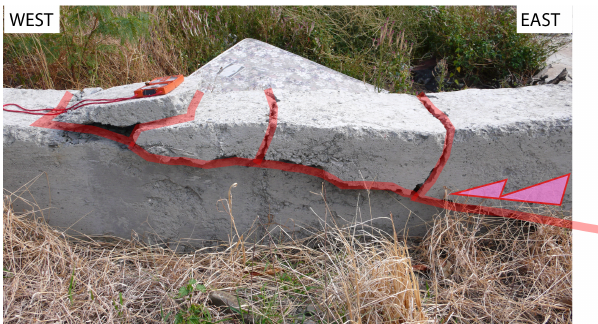
Figure 6. Field photograph of compressive features affecting re- cent concrete dykes after the Hengchun earthquake (26 Decem- ber 2006, M L = 7.0); see location in Fig. 1 near the Fang-Shan village (22.26 ◦ N, 120.66 ◦ E). The red compass gives the scale of the outcropping deformation (20cm). The thrust is associated with three back thrusts, highlighting a small pop-up (below the compass). The red arrow reveals the thrusting component that affects the new concrete